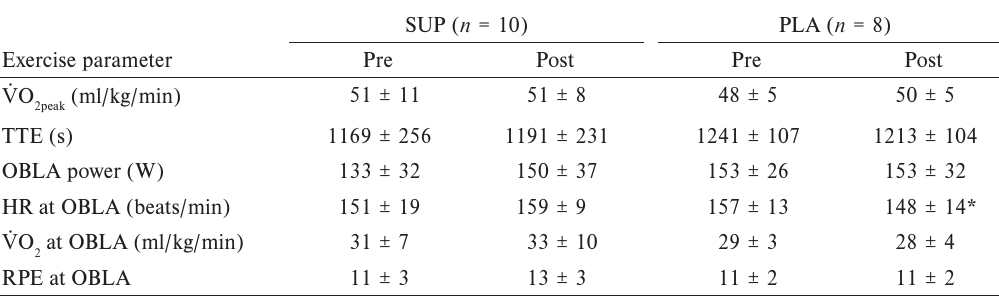
RPE at OBLA Note. SUP = supplement group; PLA = placebo group; TTE = time to exhaustion; OBLA = onset of blood lac- mentation PLA ( p <